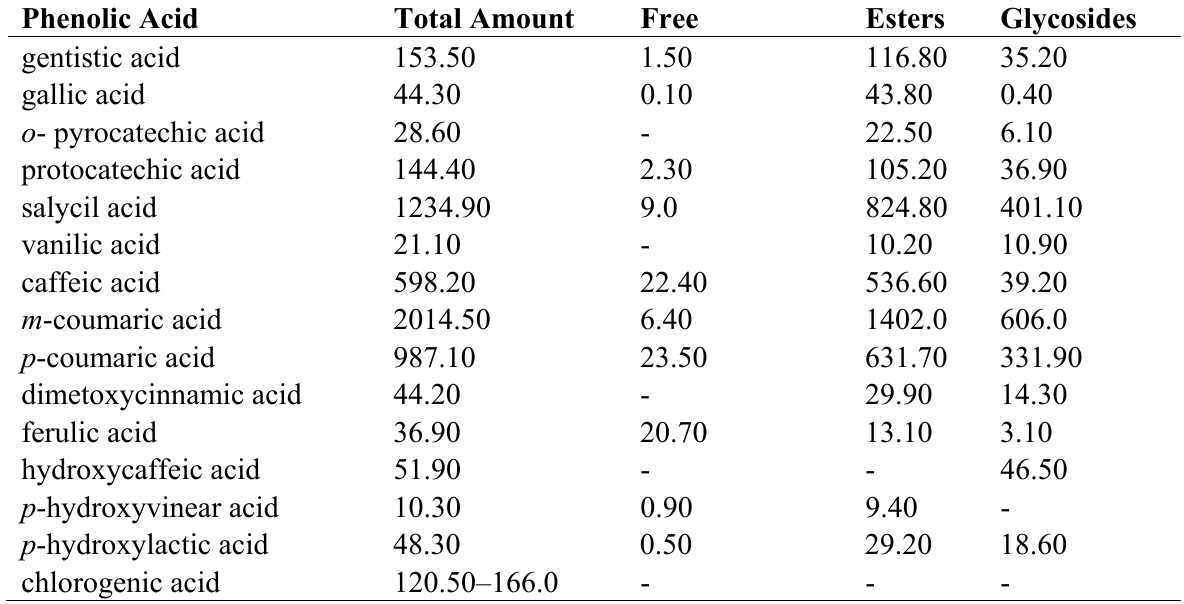
Table 1. Phenolic acids in berries of blue honeysuckle - total amount, free and bonded as esters and glycosides